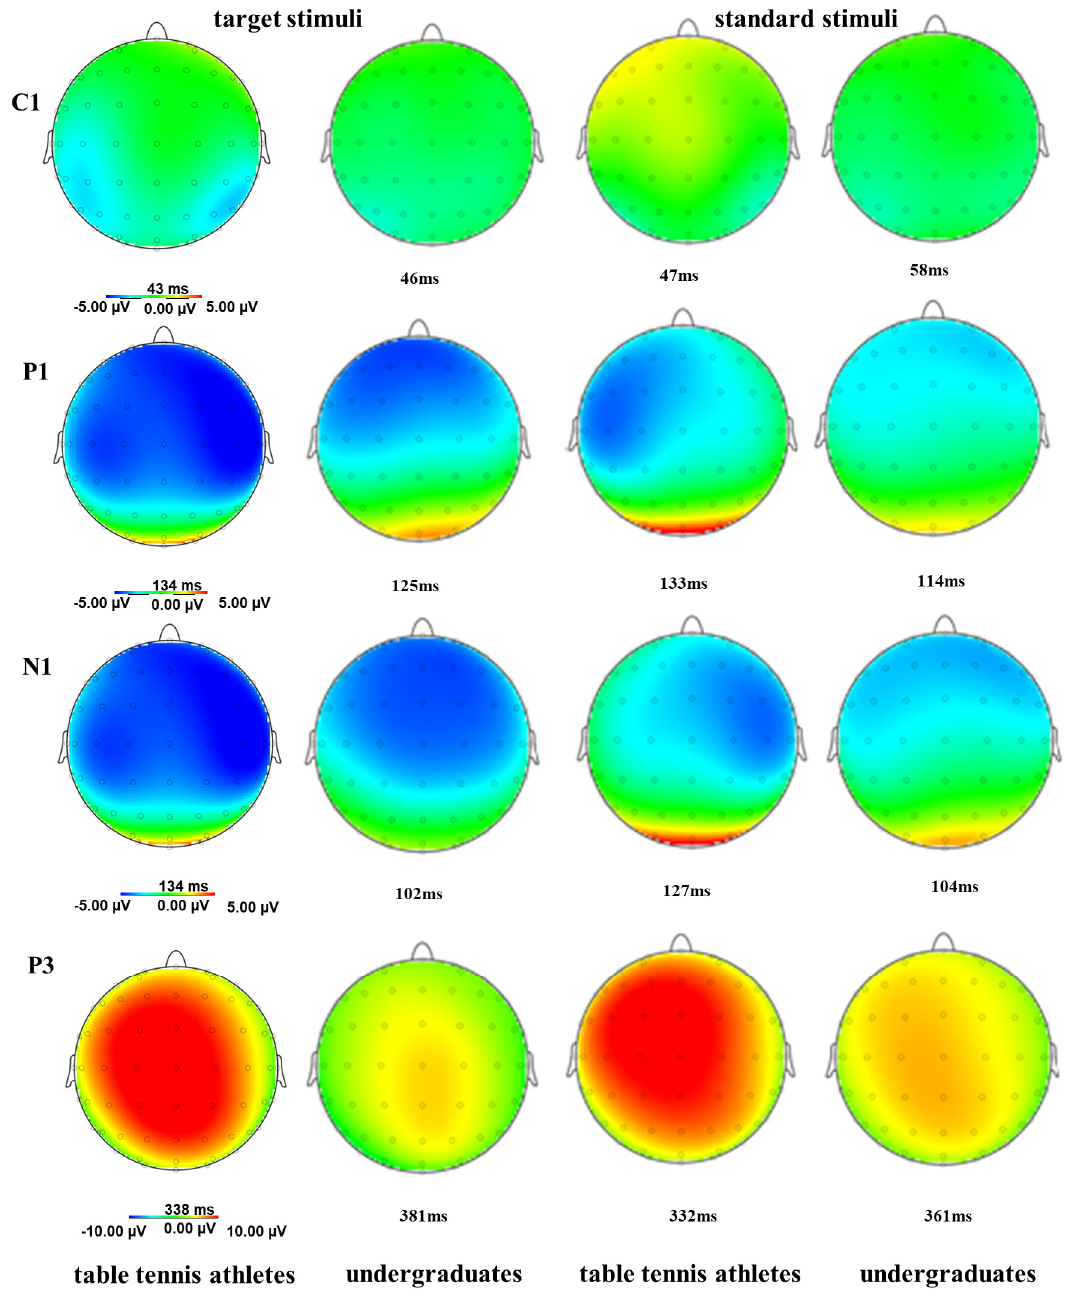
Figure 4. Scalp topographies distributions from the two groups of participants were illustrated by the mean C1, P1, N1 and P3 amplitude and latency. The distinct patterns from each component separately evoked by target stimuli and standard stimuli at the peak time point were noted. Color bar indicates mean signal amplitude in